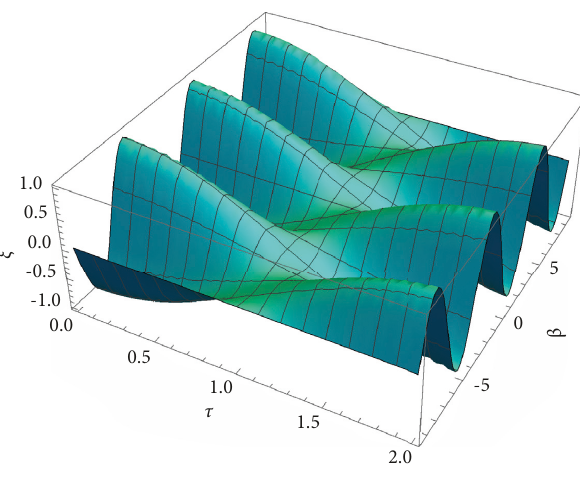
Figure 21: The real part of the exact solution to Example 3.